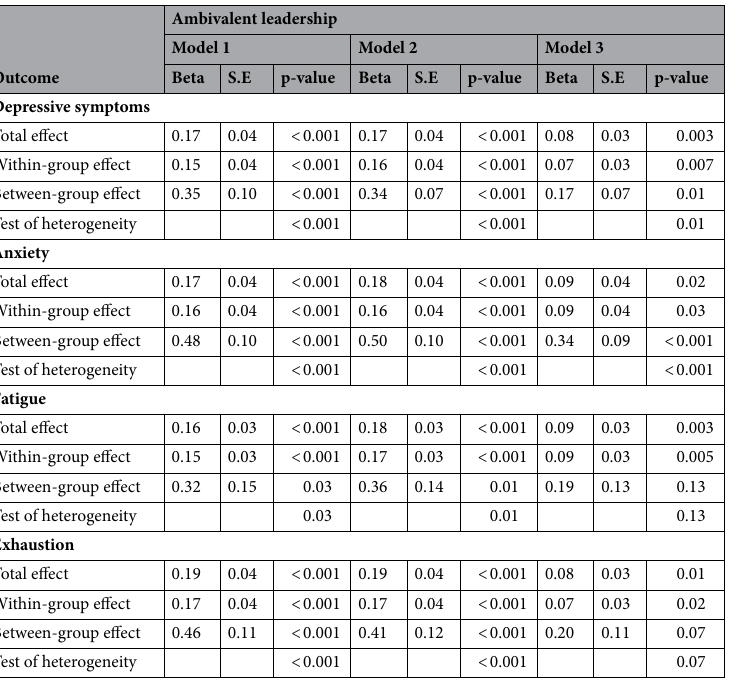
Table 3. Association of ambivalence with mental health indicators. Model 1 = adjusted for sex and age. Model 2 = adjusted for sex and age, and job characteristics and lifestyle factors. Model 3 = adjusted for sex and age, and job characteristics and lifestyle factors, and positive (positivity) and negative (negativity) supervisor behavior. Test of heterogeneity: Hausman test for difference between within-group effect and between-group